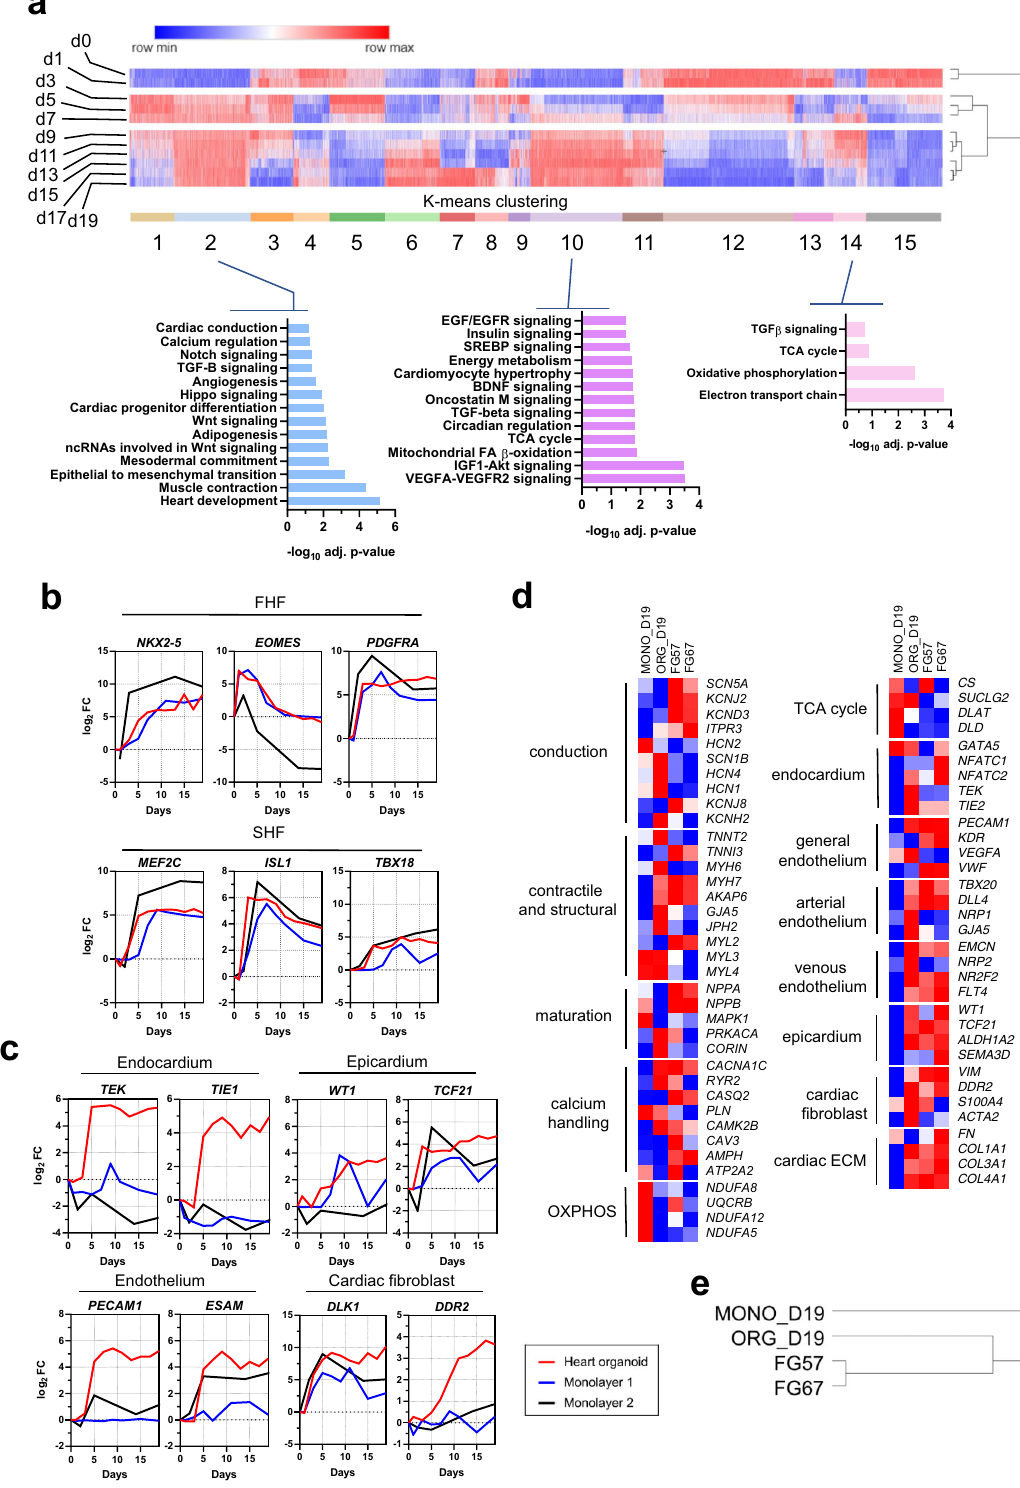
signalingBDNFsignalingCardiomyocytehypertrophyEnergymetabolismSREBPsignalingInsulinsignalingEGF/EGFRsignaling -oxidationTCAcycleCircadianregulationTGF-betasignalingOncostatinM